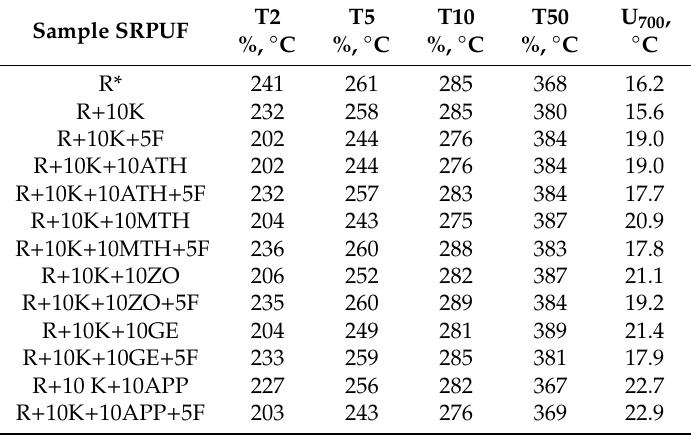
Table 3. Summary of TG results obtained during TGA measurements carried out in a nitrogen atmosphere.